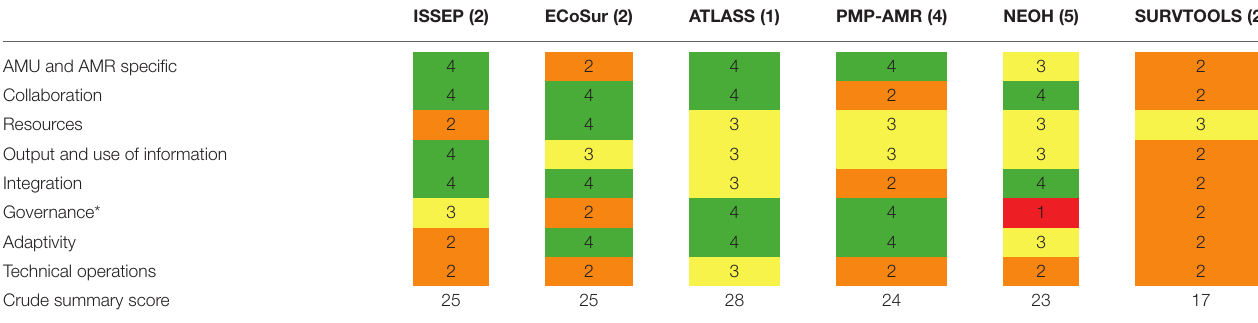
TABLE 6 | Results of scoring of six tools for AMR surveillance evaluation according to eight themes describing the scope of the evaluation tool (the number of times the tool was assessed is given in the